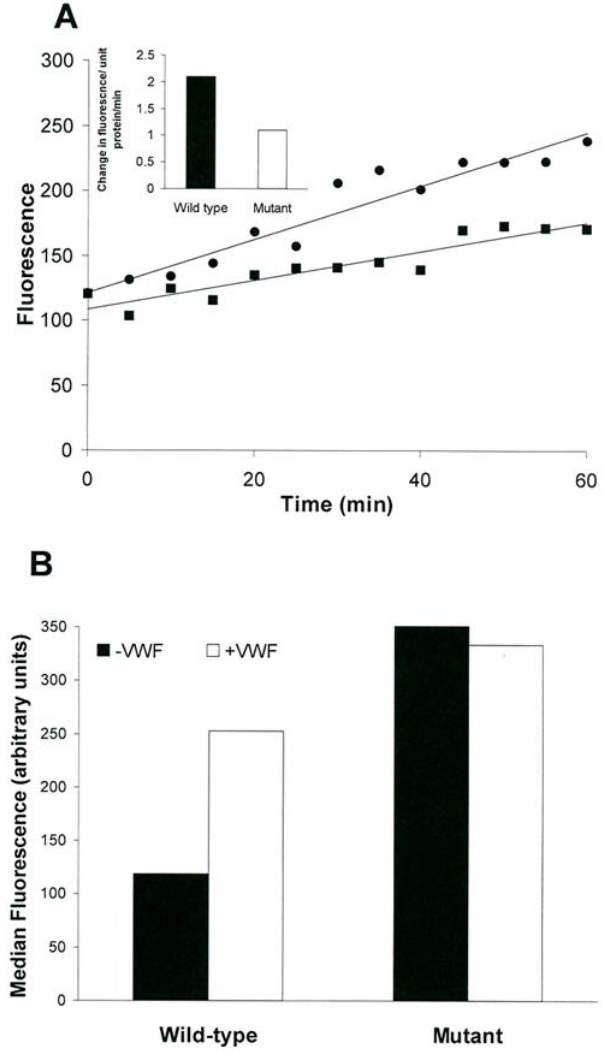
Figure 8. A functionally deficient mutant of ADAMTS13 shows N minimal conformation change in the presence of VWF. (A) ) ADAMTS13s were Activity of wild-type ( & ) and the P475S mutant ( measured by the FRET-VWF73 assay as described previously. Inset shows the activity of wild-type (filled bar) and the mutant (empty bar) ADAMTS13. (B) Wild-type and the P475S mutant ADAMTS13 were incubated with either BL154G alone (filled bars) or in the presence of 500 m l of VWF stock (empty bars). The VWF was incubated with ADAMTS13 prior to addition of the polyclonal Ab. Binding of polyclonal Ab was monitored by flow cytometry. The figures represent data from one of three independent experiments.